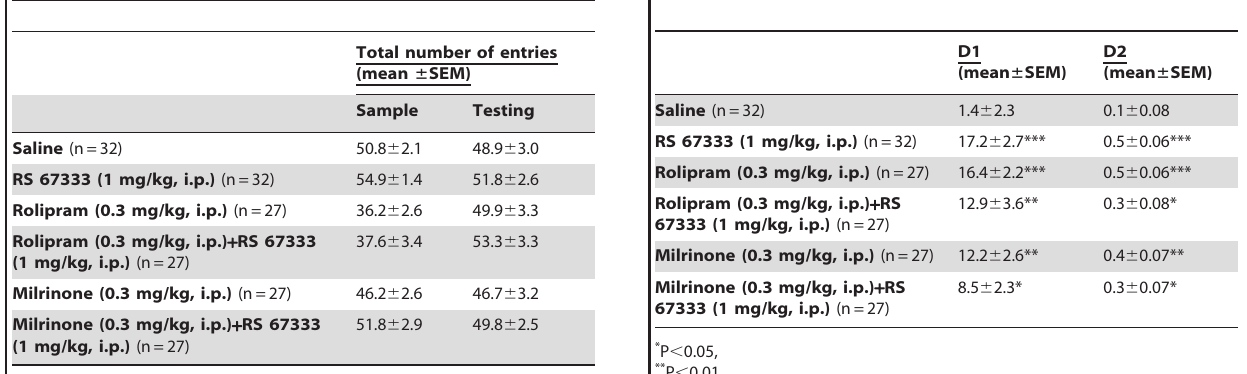
Table 2. Locomotor activity measured during the sample and the testing trails in the object recognition task.